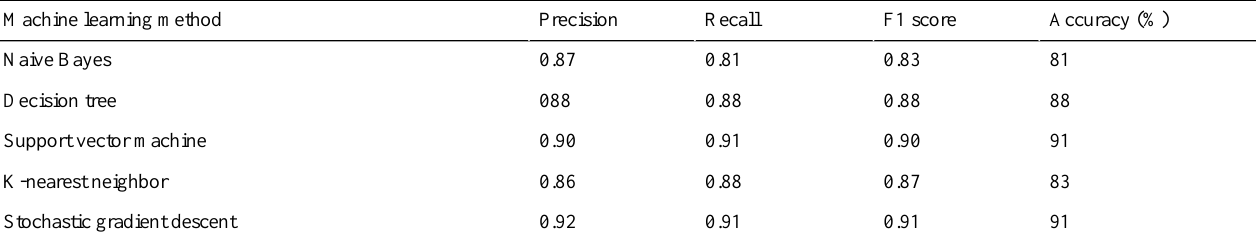
Table 2. Performance of machine learning